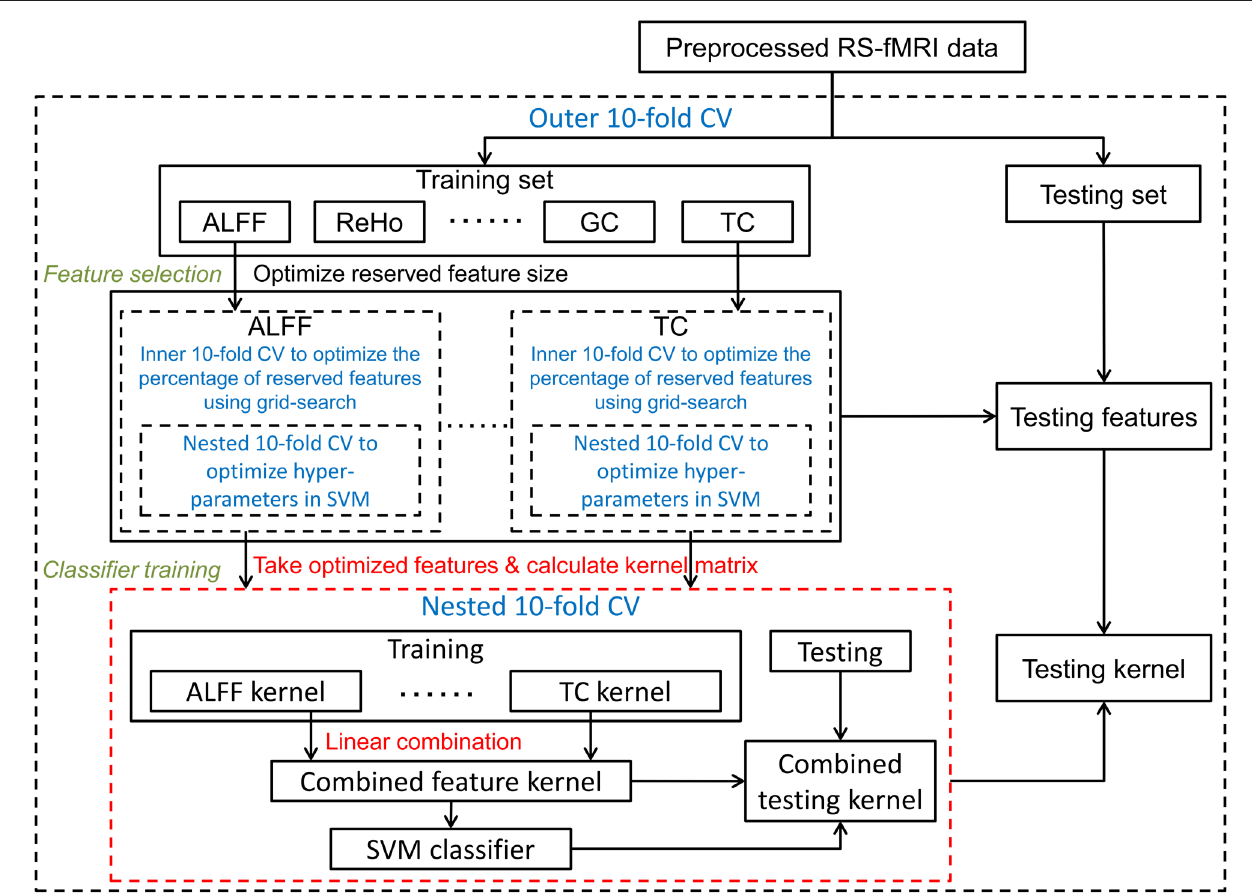
FIGURE 2 | Optimized framework of kernel combination: kernel matrices were calculated separately on each optimized feature set, and were then linearly combined as a final kernel. Cross-validation parts are in blue font and dashed lines. To distinguish it from the other two frameworks, the kernel combination part is illustrated in